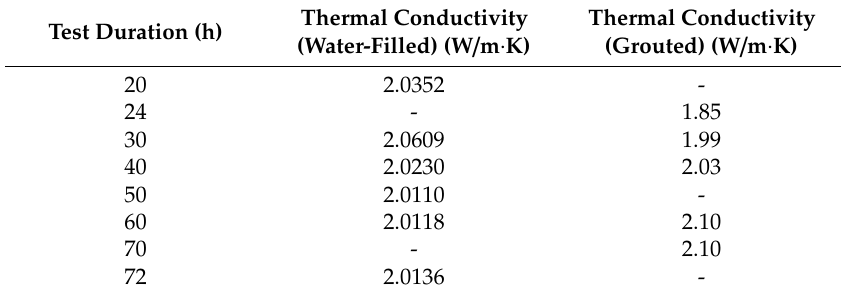
Table 11. Comparison of the thermal conductivity results of a water-filled well (this work) and a grouted